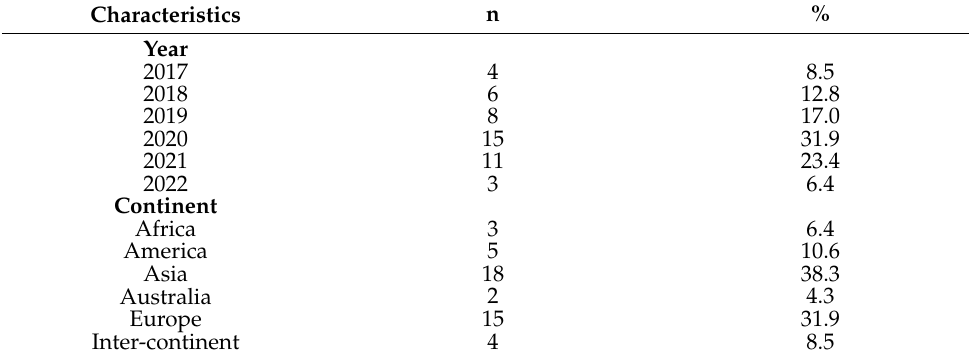
Table 3. Research characteristics.